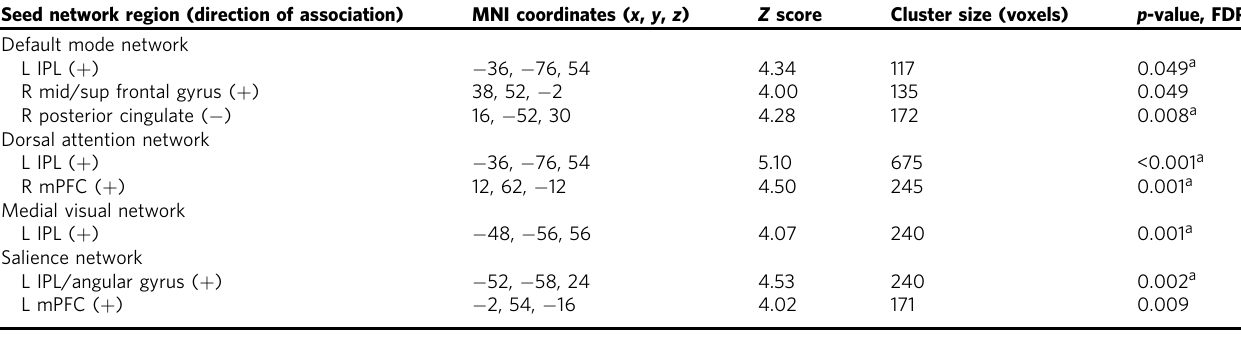
Table 1 Seed network to whole-brain connectivity analyses at baseline Seed network region (direction of